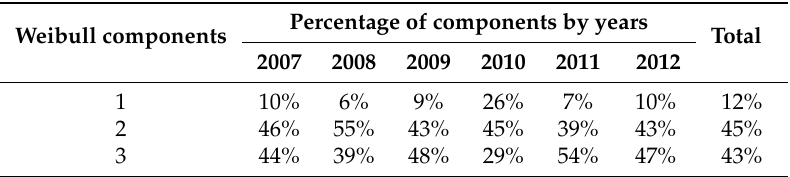
Table 2. Relative frequencies of the optimal number of Weibull components (AIC approach) using aggregated wind power generation data.